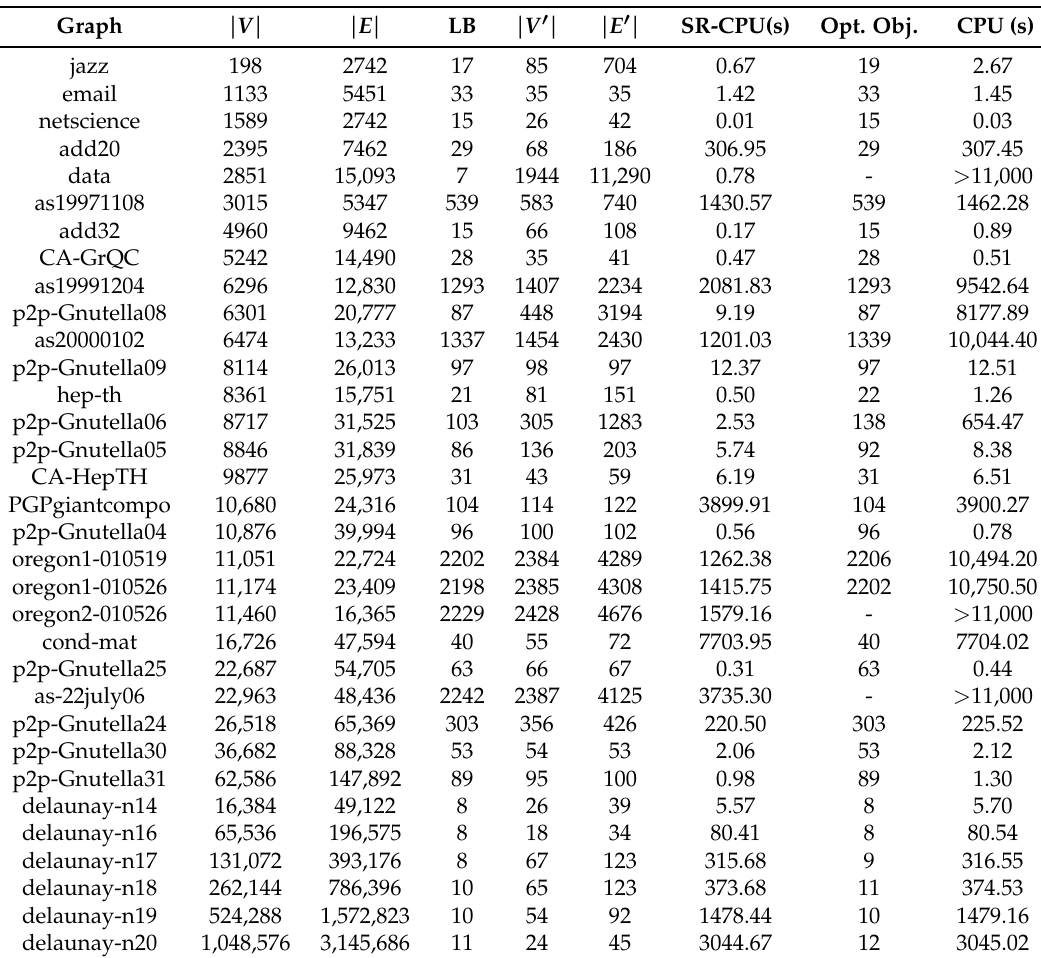
Table 2. Computational results for the MEB problem on instances from DIMACS Clustering challenge and SNAP